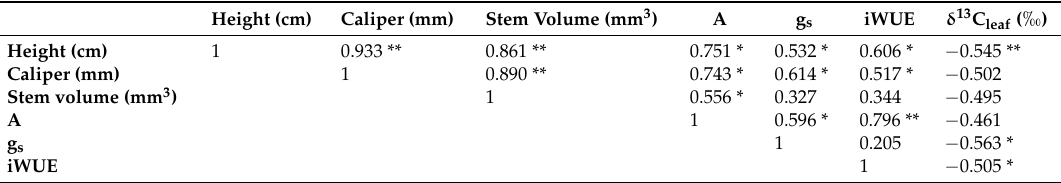
Table 3. Pearson’s correlations (r) analysis among physiological variables under optimal growth condition in greenhouse for selected progeny growth at two